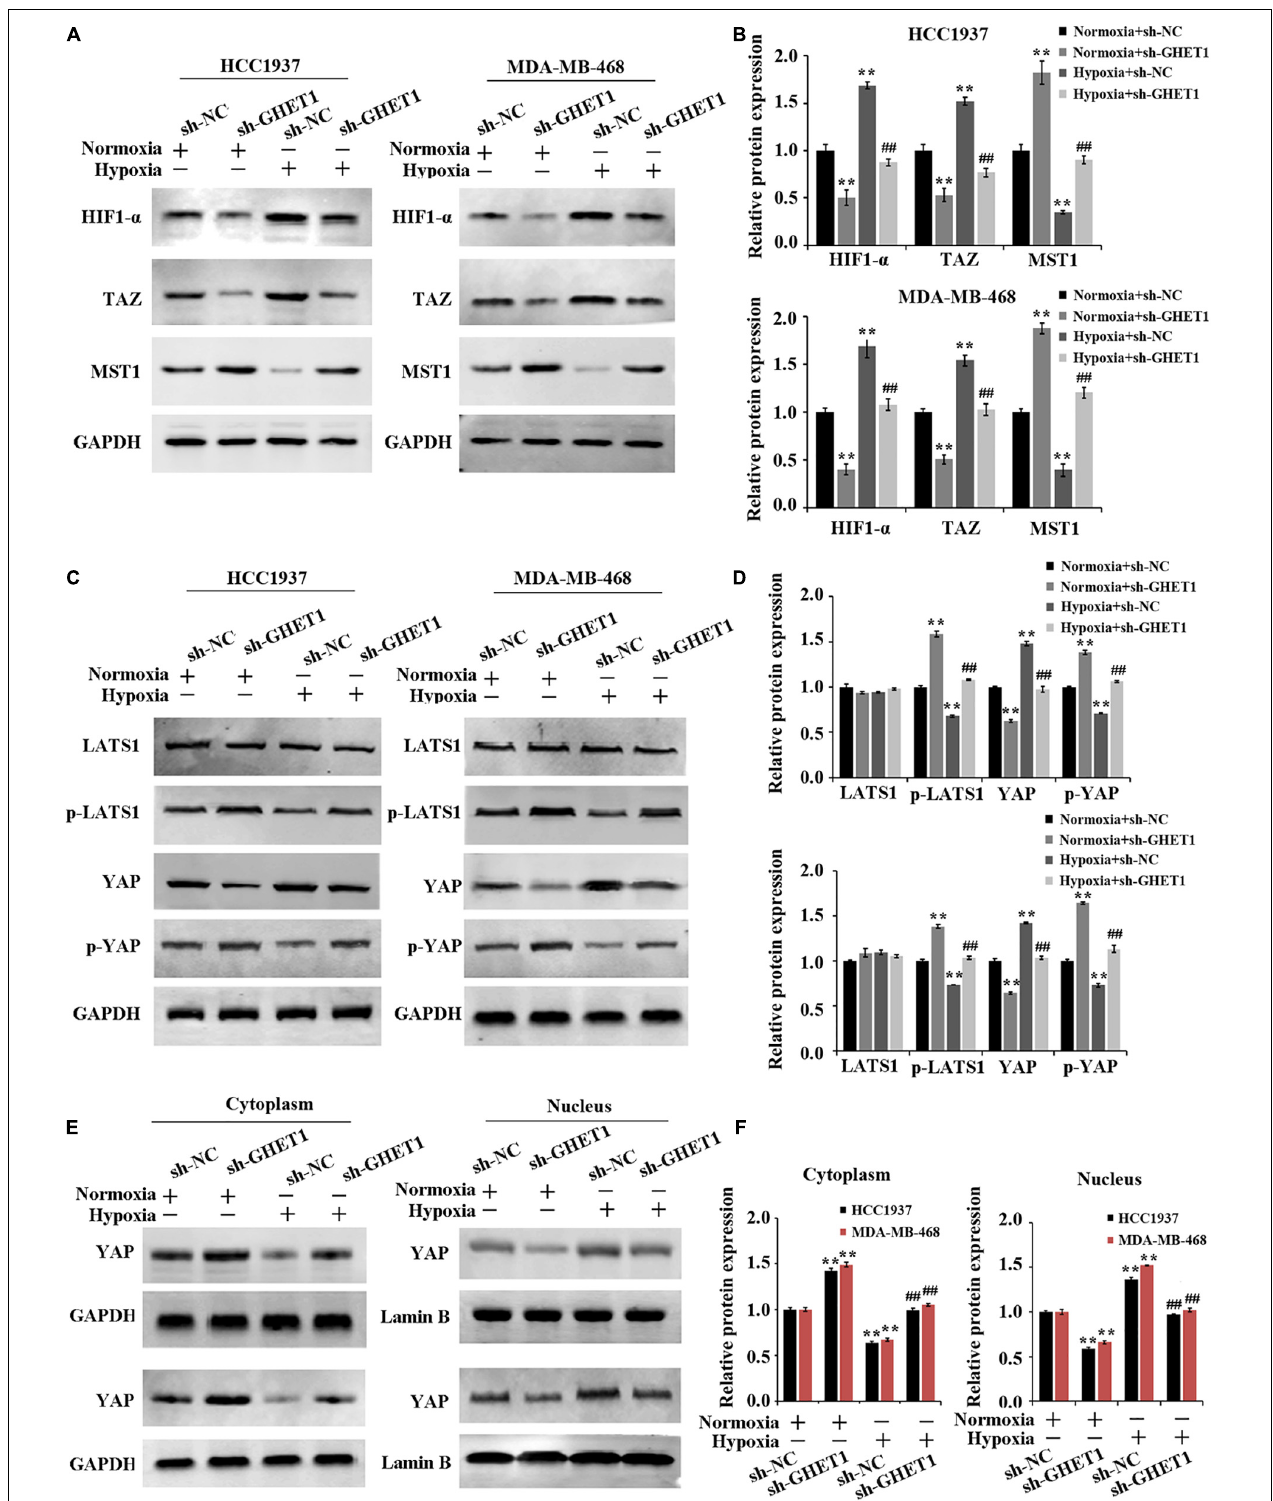
FIGURE 4 | Inhibition of hypoxia-induced Hippo/YAP pathway activation and YAP nuclear translocation by downregulation of lncRNA GHET1 MDA-MB-468 and HCC1937 cells were transfected with sh-GHET1 or control plasmid under normoxia and hypoxia conditions. (A–D) Protein expression of HIF- α and the indicated Hippo/Yap pathway were measured by western blot. (E,F) Expression of YAP protein in the cytoplasm and nucleus of TNBC cells was detected by western blot. ** P < 0.01 vs. Normoxia + sh-NC group; ## P < 0.01 vs. Hypoxia + sh-NC group.